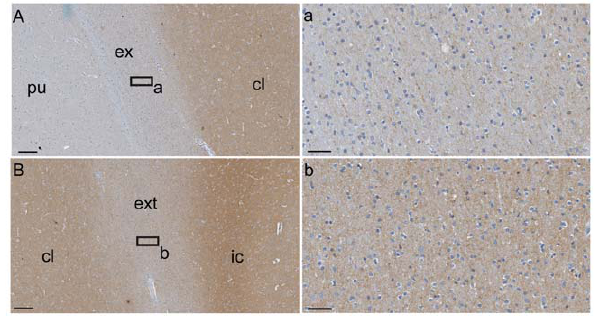
Figure 3. Gng2-ir distribution in the capsules. (A, B) Low magnification images. (a, b) Higher magnification images of A and B correspond to (a) the external capsule (ex) and (b) to the extreme capsule (ext). pu, putamen; ic, insular cortex; cl, claustrum. Scale bar =200 m m (A, B), 50 m m (a, b).